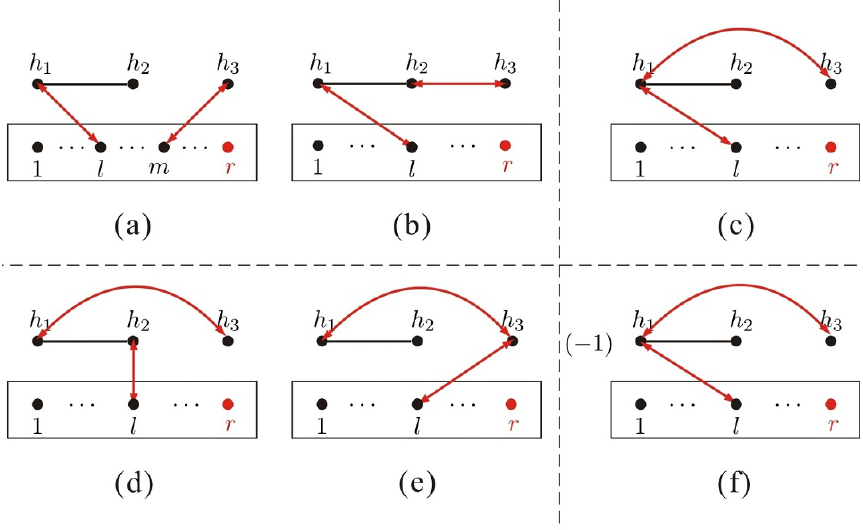
Figure 7 . Graphs (a), (b), (d) and (e) are physical graphs, which are constructed by the re(cid:12)ned graphic rule, for the skeleton F 0 = (cid:12)gure 6 (i). Graphs (d) and (e) are spurious graphs for the skeleton F 0 = (cid:12)gure 6 (i). All spurious graphs cancel with each other.